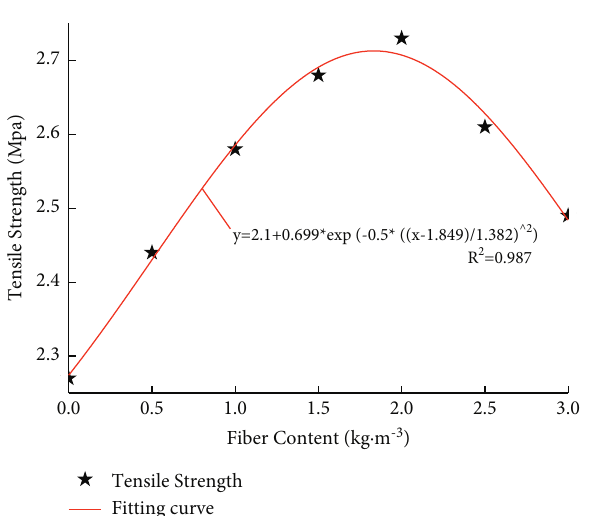
Figure 5: Splitting tensile strength fitting curve.